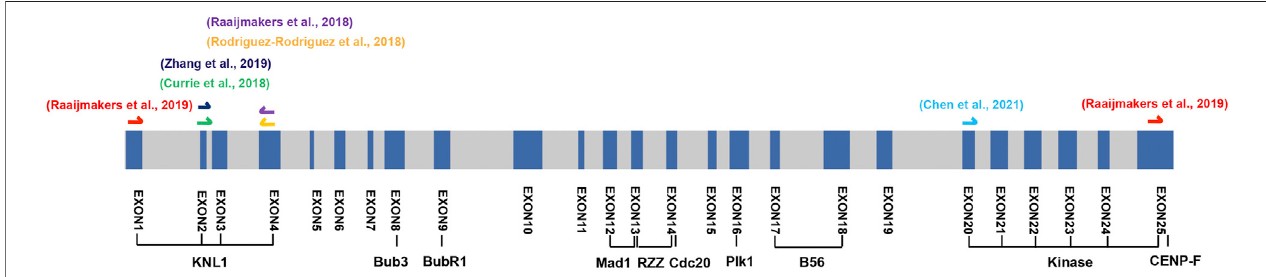
FIGURE5| SchematicofthetargetedexonsoftheBub1knockoutcelllines.TheschematicshowsalltheexonsofBUB1inhumangenome.Theexonstargetedby CRISPR/Cas9 from a number of studies are marked on top of the schematic. We propose targeting exon 8 (GLEBS domain) or co-targeting exon 9 (BubR1 binding domain) and exon 12 (CD1 domain) may cause lethality. The lengths of exons, but not introns are proportional to the actual lengths on